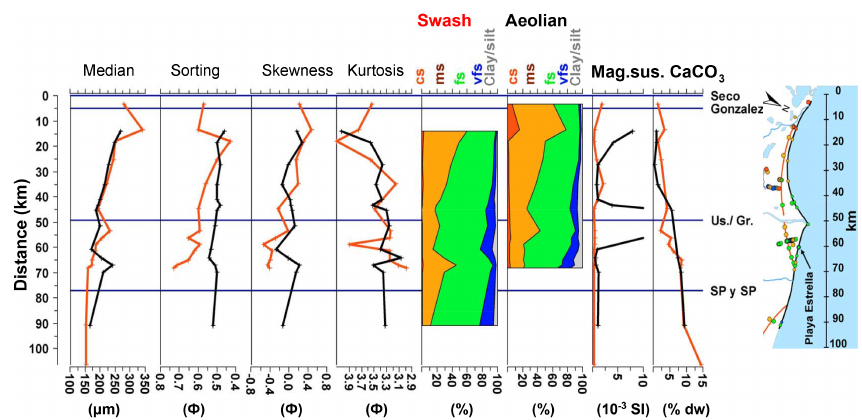
Figure 6. Shore-parallel variability in grain-size parameters of swash (red) and aeolian (black) facies. Vfs: very fine sand; fs: fine sand; ms: medium sand; cs: coarse